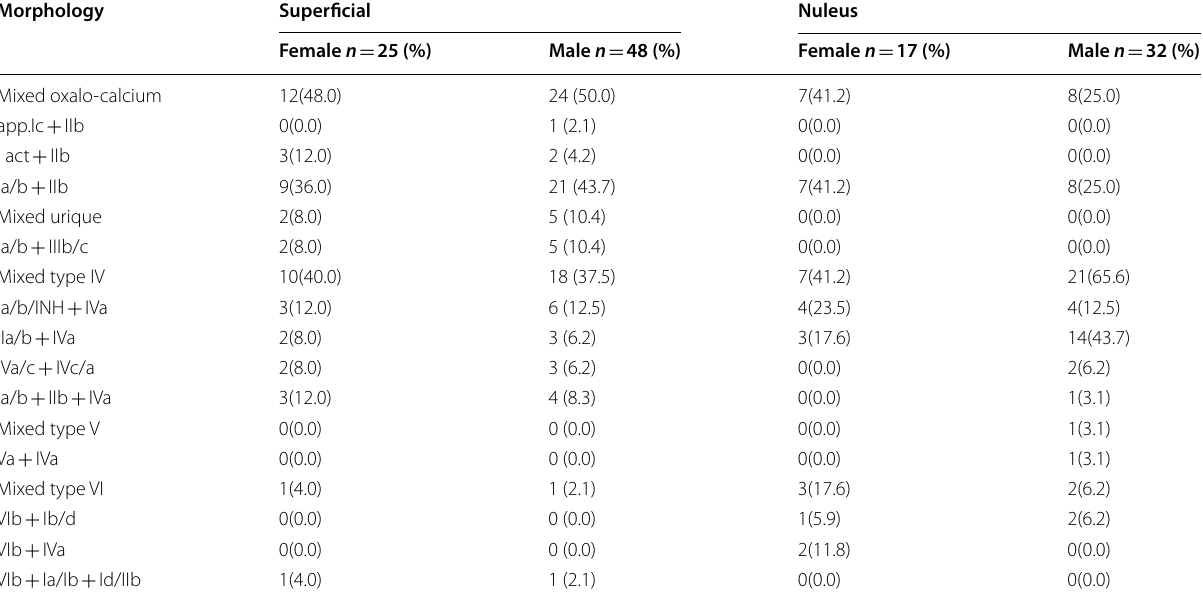
Table 4 Morphological description of urinary stones by gender